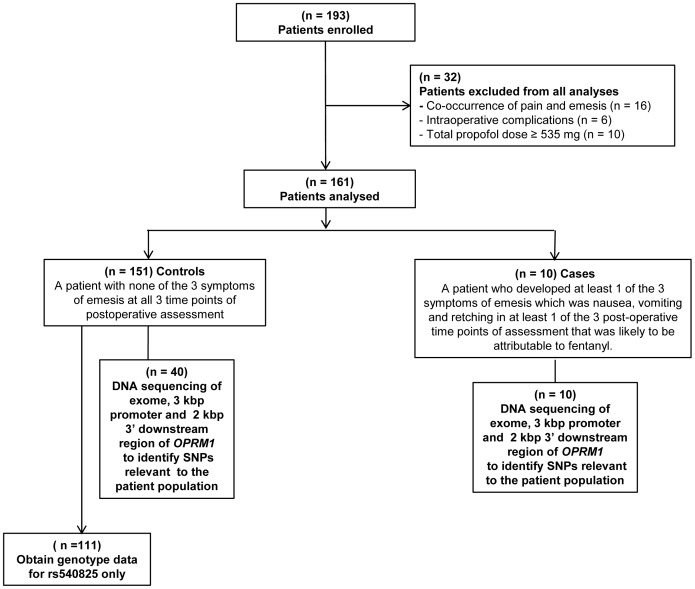
Flowchart outlining the patients enrolled, analysed, classified as cases or controls and sequenced for OPRM1 SNPs.